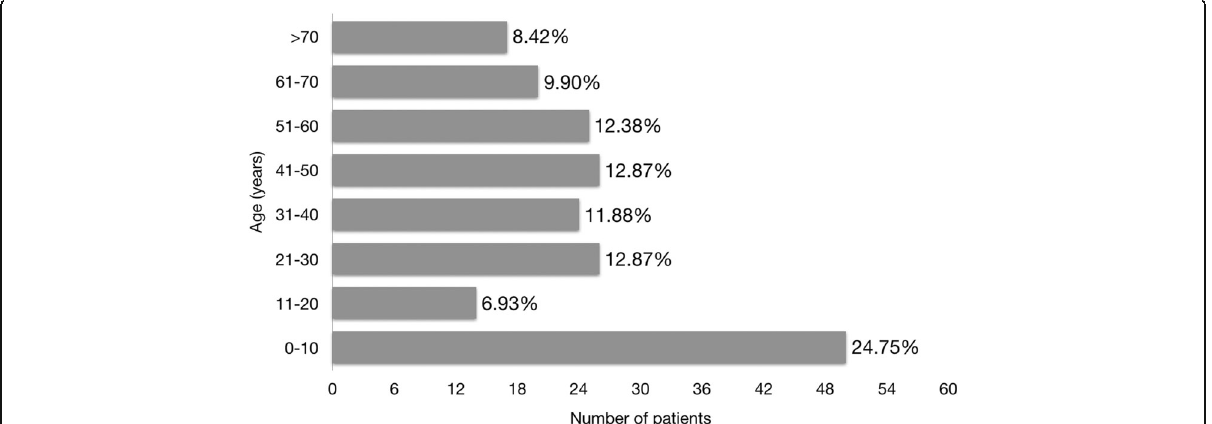
Fig. 1 Age distribution of endophthalmitis cases ( n = 202). The largest age group affected was 10 years old and below, constituting one-fourth of the cases, while at least half of the patients were within the working age group